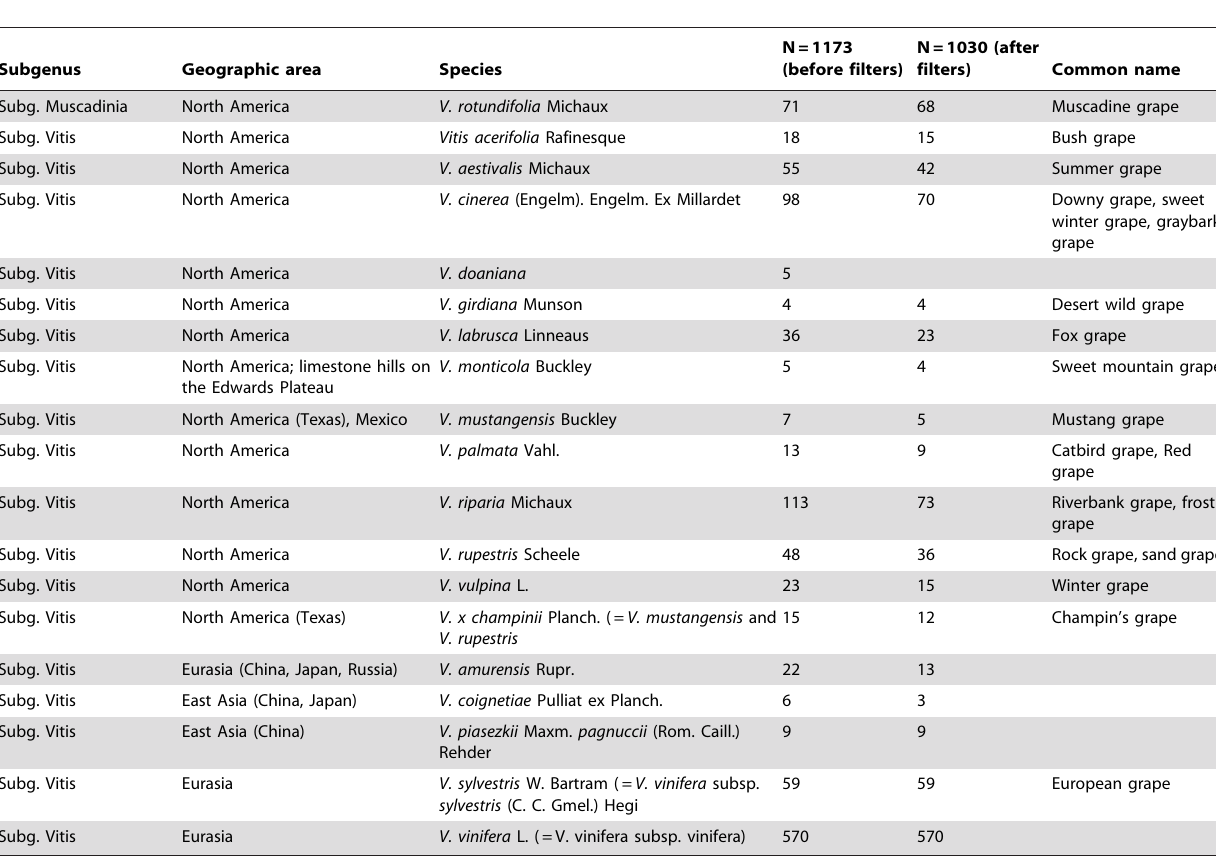
Table 1. Accessions used in the SNP